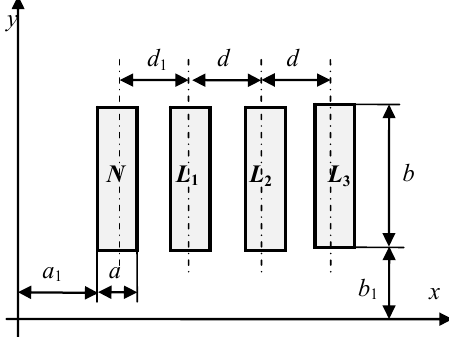
Figure 2. Unshielded bus duct manufactured by the Holduct company [5].